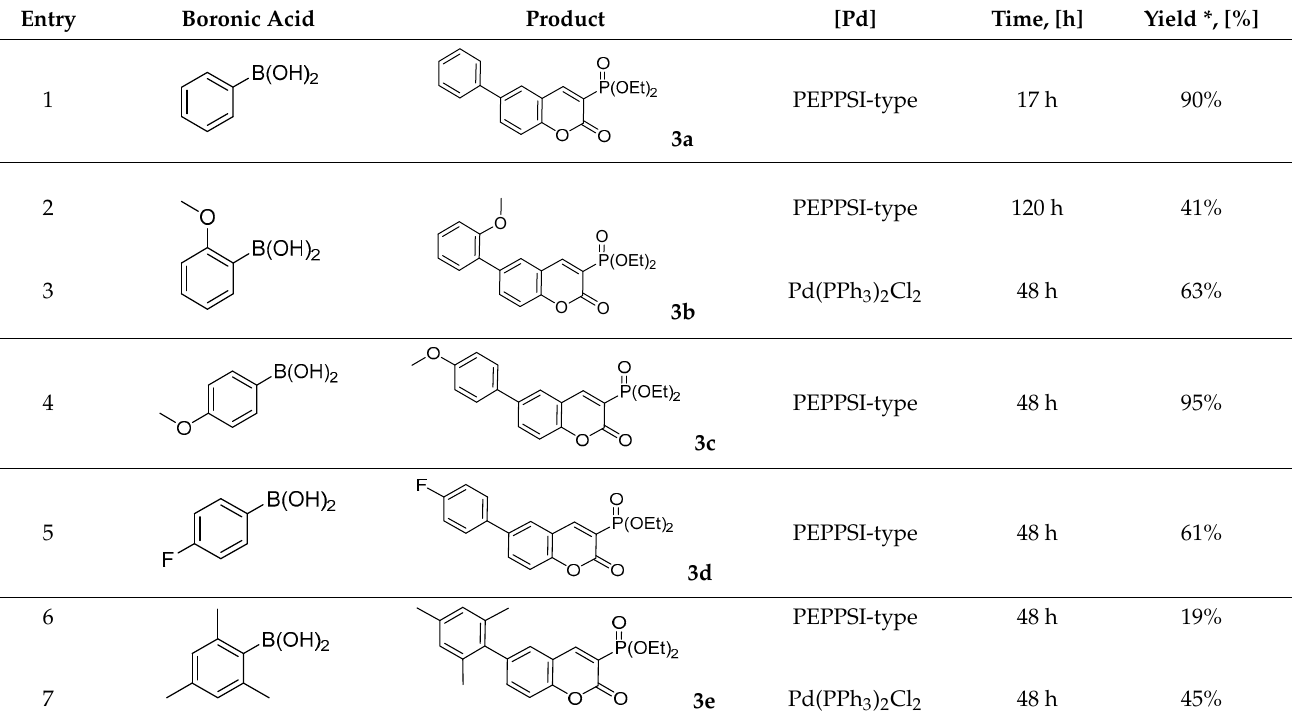
* Isolated yields after column chromatography.